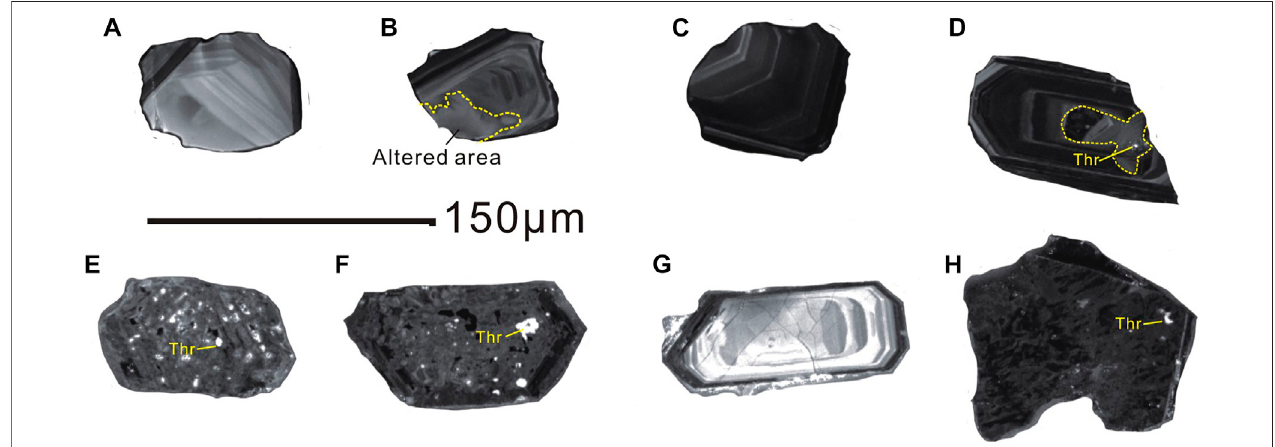
FIGURE 7 | Zircon CL images of the Jianfengling granite (A – D) porphyritic biotite monzogranite. Alteration is extensive on the zircon grain margin (E,F) medium- fi ne-grained biotite monzogranite (G,H) medium-grained biotite monzogranite. Thr, thorite.